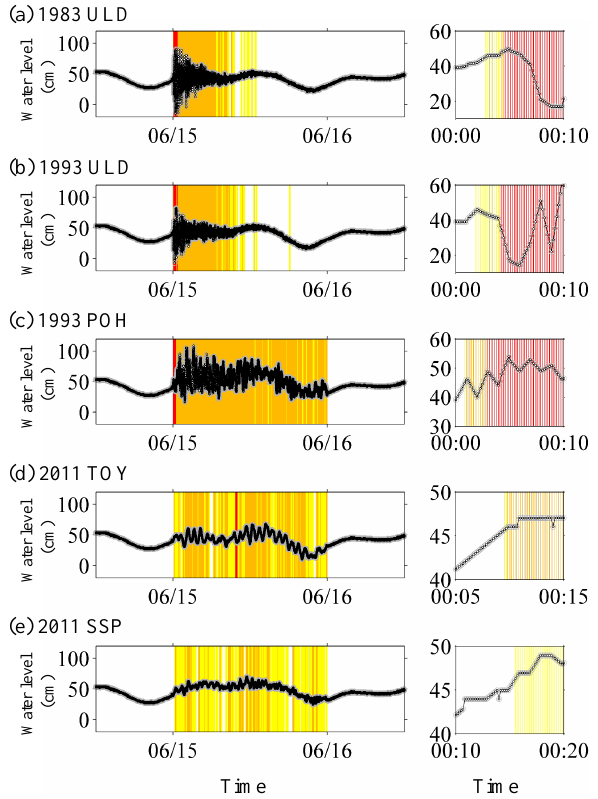
Figure 13. Synthetic tsunami records combining the records of tide stations with the background records of the Ulleung-do surge gauge: (a) 1983 ULD (Ulleung-do), (b) 1993 ULD (Ulleung-do), (c) 1993 POH (Pohang), (d) 2011 TOY (Tongyeong), and (e) 2011 SSP (Seongsanpo). For clarity, the records near the tsunami arrival time are zoomed in on the right side. The arrival time is fixed to 15 June 2011, and the event period is set to 24h. Vertical lines represent the alarm: warning (red), advisory (orange), and watch (yellow).